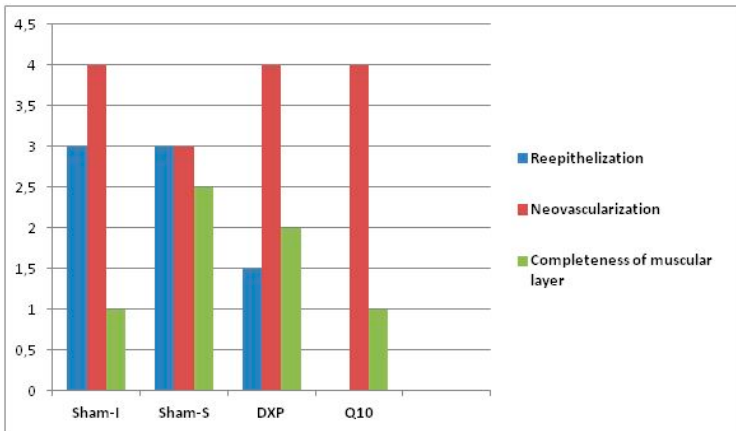
Figure 7. Bars represent the reepithelization, neovascularization, and muscular layer completeness score values. J. Clin. Med. 2018 , 7 , x FOR PEER REVIEW